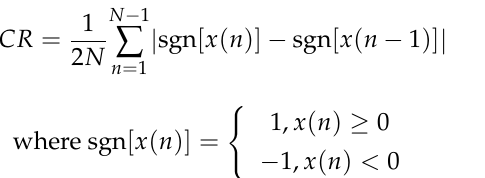
Table 1. Demographic data of patients with ADHD.